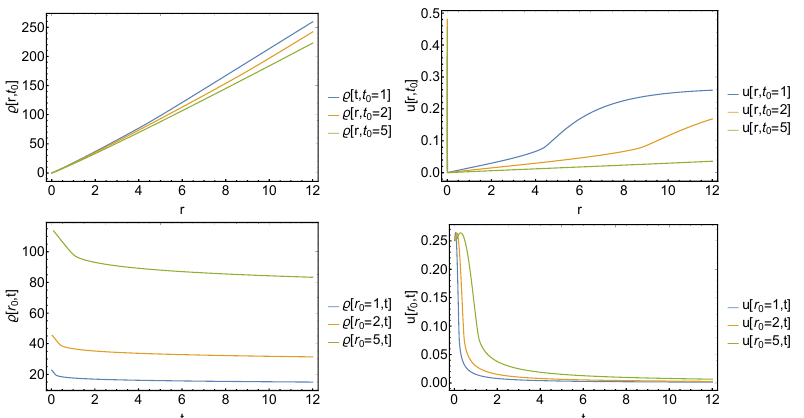
Figure 3. The shape functions of Equation (7) for different EoS strength parameters: w = − 1 (green), − 0.33 (black), 0 (red), and 0.33 (blue). The solid and dashed lines represent shape functions of density g ( ω ) and velocity f ( ω ) , respectively. Note that all velocity curves coincide. The initial conditions are f ( 10 − 3 ) = 0.5 and g ( 10 − 3 ) = 0.01.